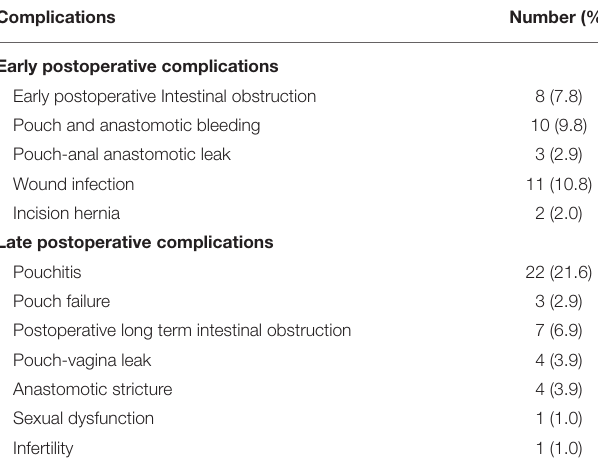
TABLE 2 | Main postoperative complications of